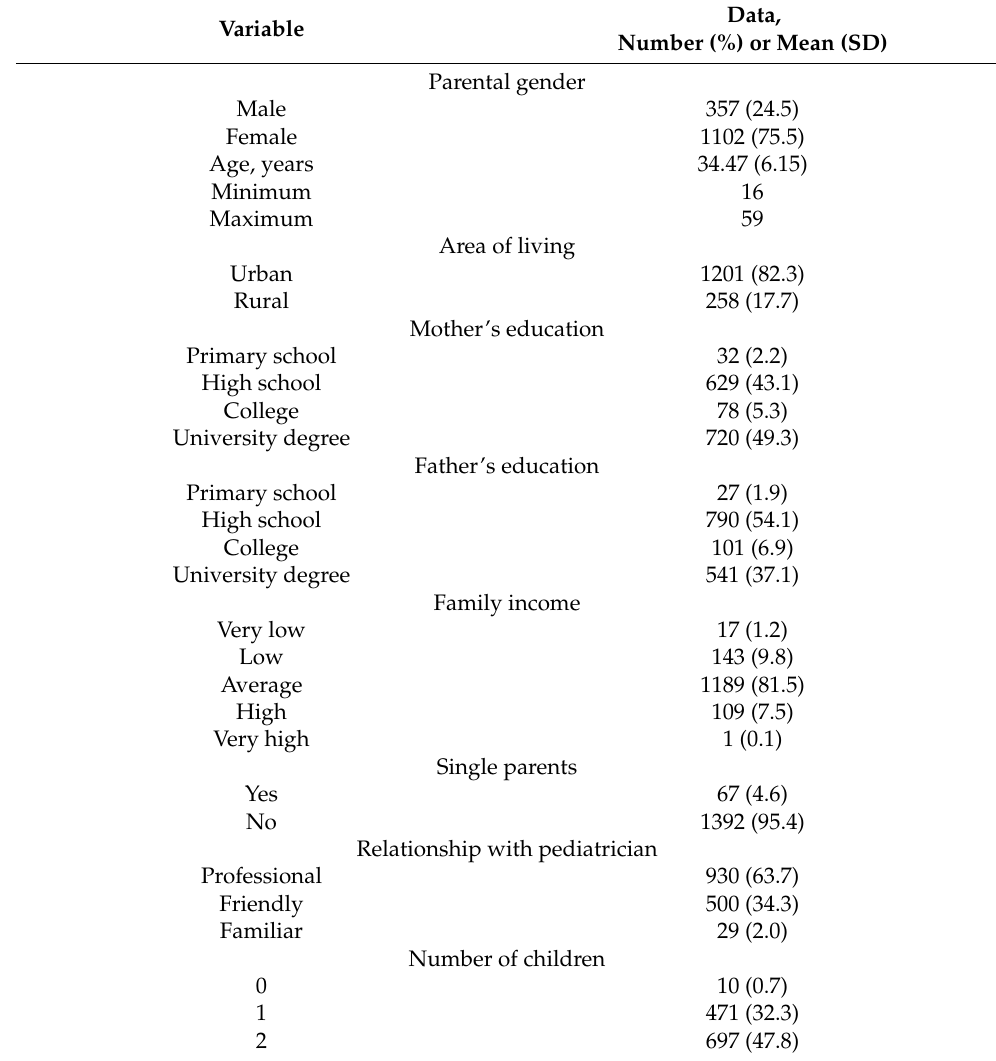
Table 1. Demographic characteristics of the